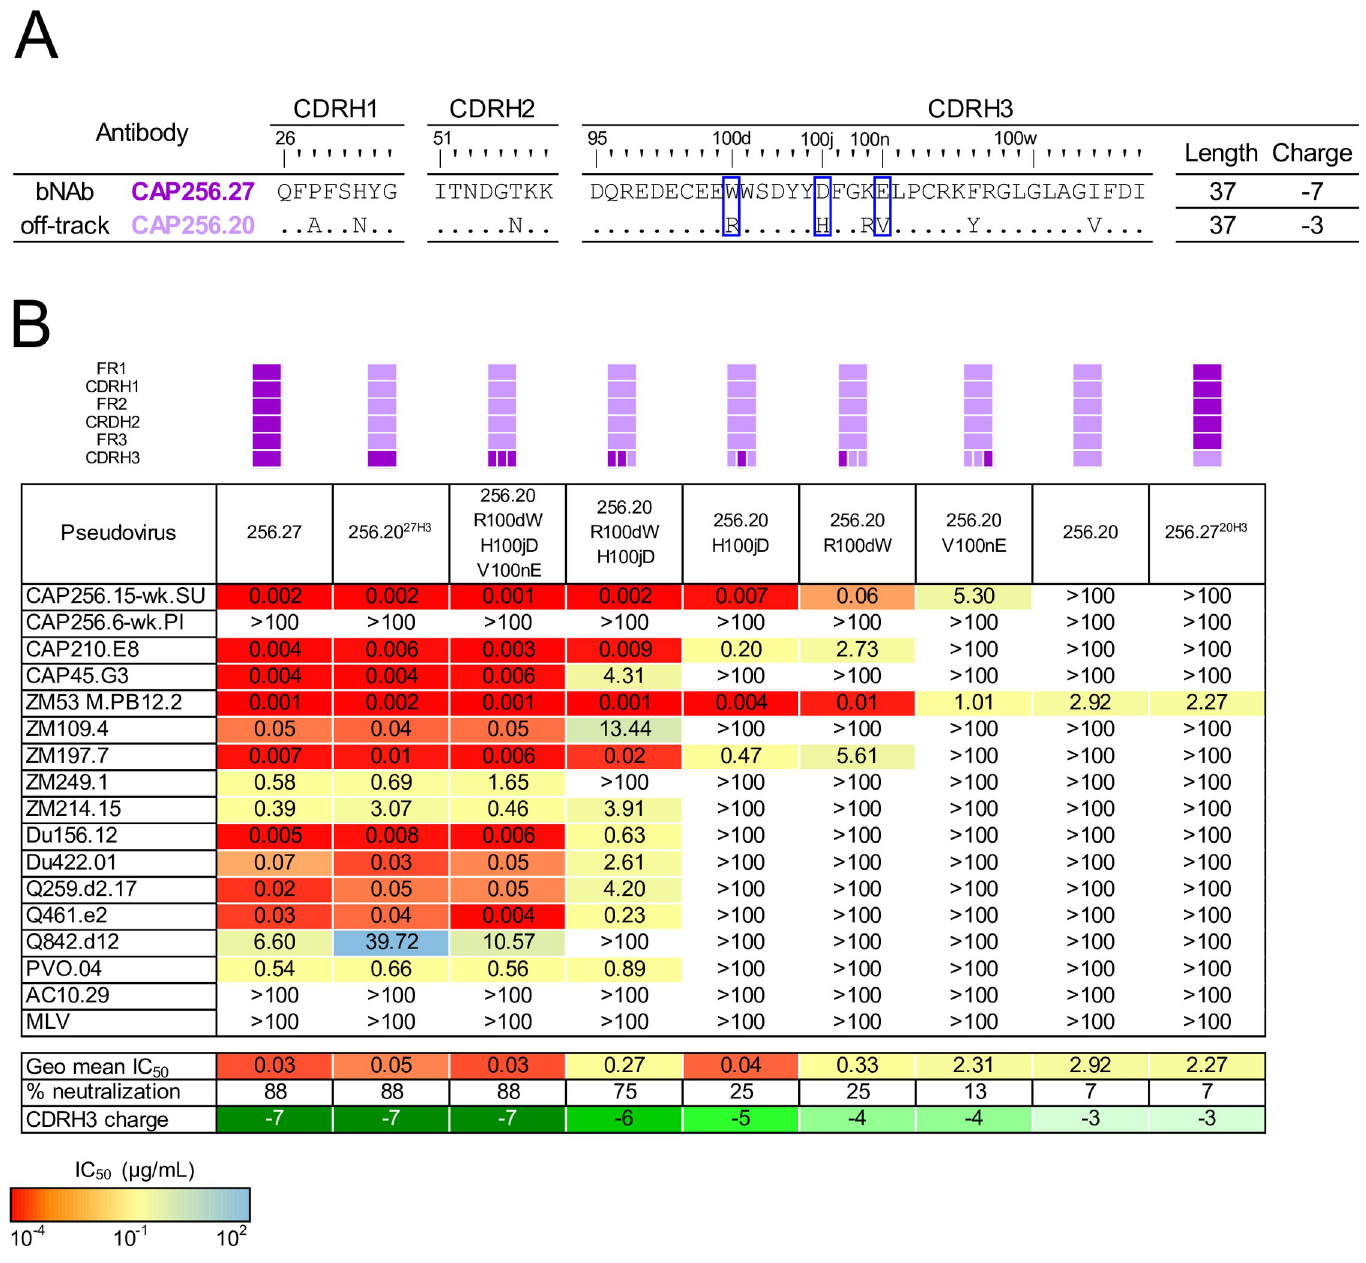
Fig 4. The CDRH3 alone restricts the neutralization breadth and potency of CAP256.20. (A) Comparison of the CDR sequences of CAP256.20 (light purple) and CAP256.27 (purple). The blue box highlights key off-track mutations. (B) Neutralization data using mutants and chimeras (indicated schematically above the table) between CAP256.27 and CAP256.20, with neutralization potency shown by color, as indicated in the key. Neutralization data represents the arithmetic mean titers (IC 50 , μ g/mL) from at least two